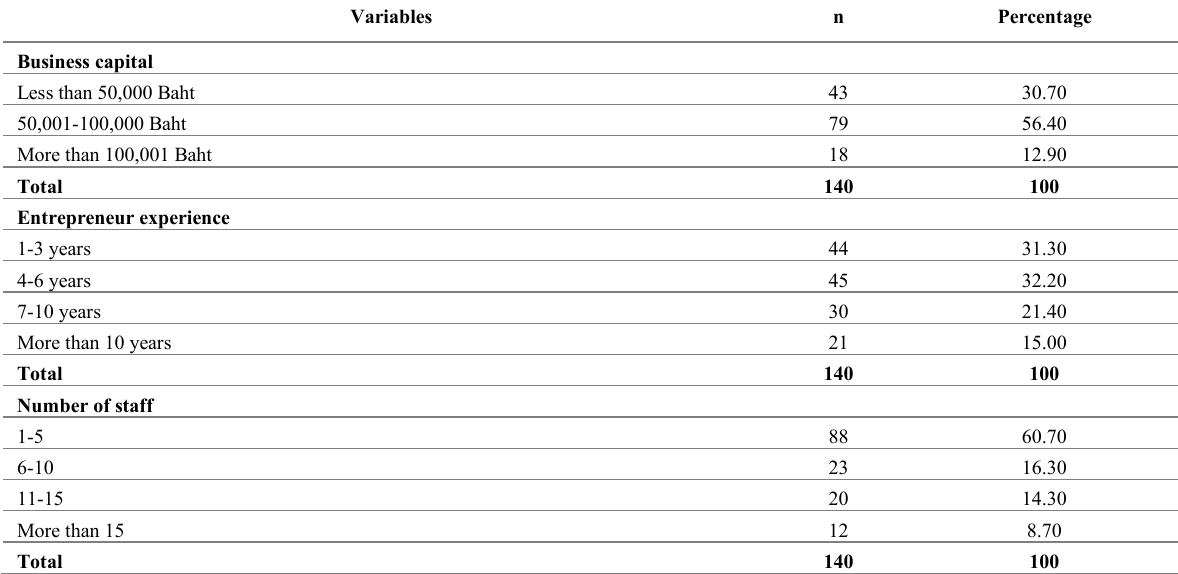
Table 3: Results of Entrepreneurs divided by business capital, entrepreneur experiences and numbers of